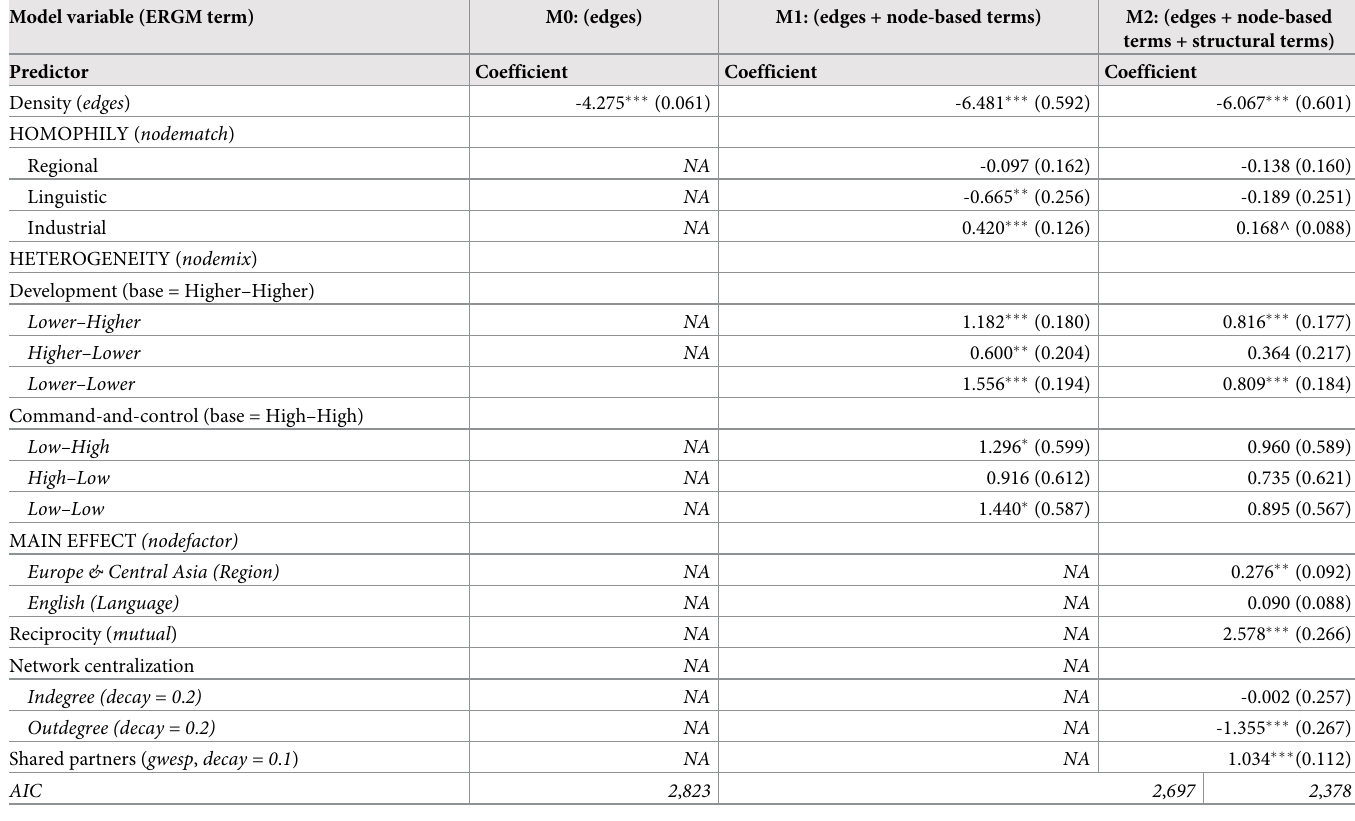
Table 3. Results of the ERGM to model the probability of inter-city ties as a function of city